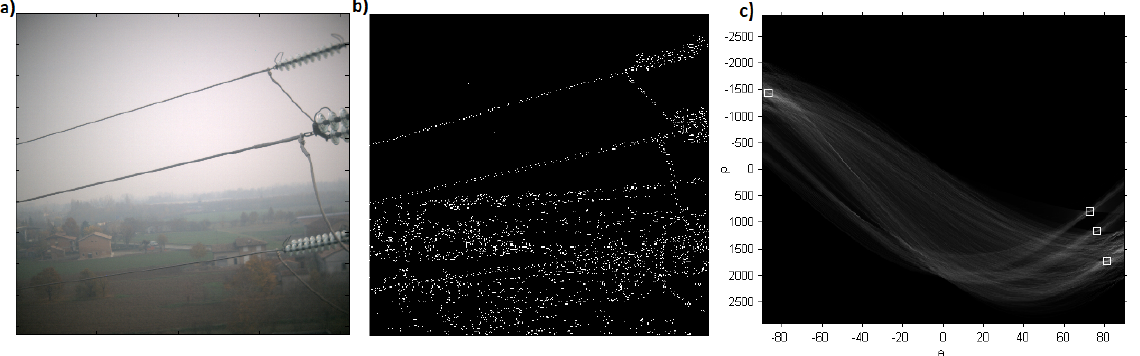
Figure 8. ( a ) Visible image of the tower and power cables; ( b ) Edges extracted from the visible image using Canny edge detector; ( c ) Detected peaks with Hough transform, where peaks correspond to the length of the line. ρ is the perpendicular distance of the peak to the origin and θ correspond to the angle. Occurrence of all positive angled peaks correspond to power